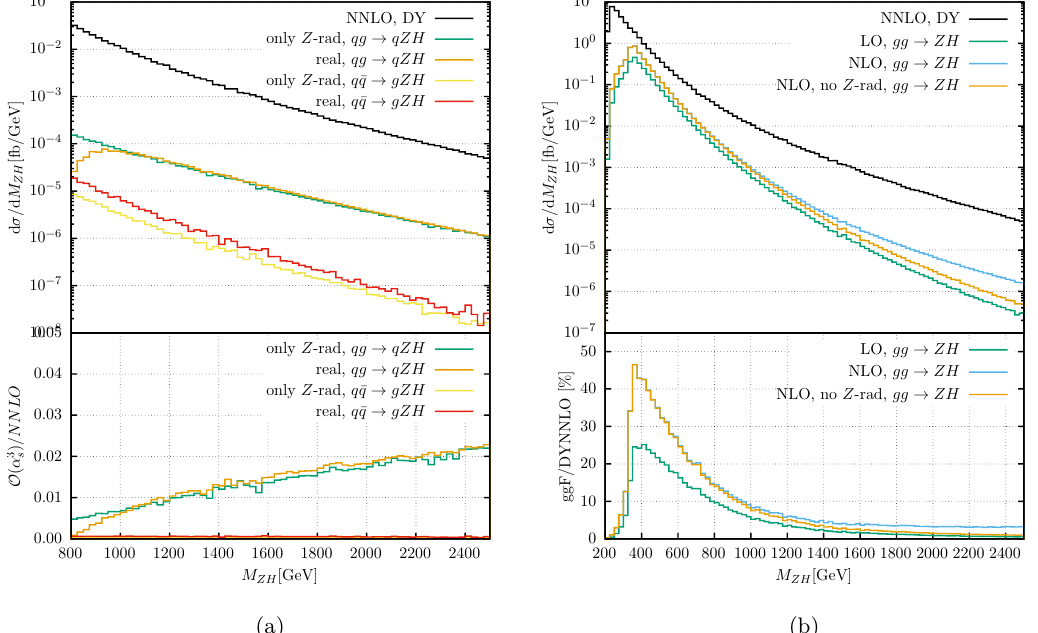
Figure 5. (a) Various contributions to ZH production at O ( α 3 ) : the real-emission contributions s from the qg and q ¯ q channel that include all the diagrams considered in this paper are shown as orange and red lines, respectively. The contributions to the same channels including only the Z - radiated diagrams are shown as green ( qg ) and yellow ( q ¯ q ) lines. The Drell-Yan-like contribution at NNLO is shown as a black line. (b) Comparison of the invariant-mass distribution for gg → ZH at LO and NLO with the Drell-Yan-like contribution at NNLO. For gg → ZH at NLO, the results with (blue) and without (orange) the contribution from the Z -radiated diagrams are